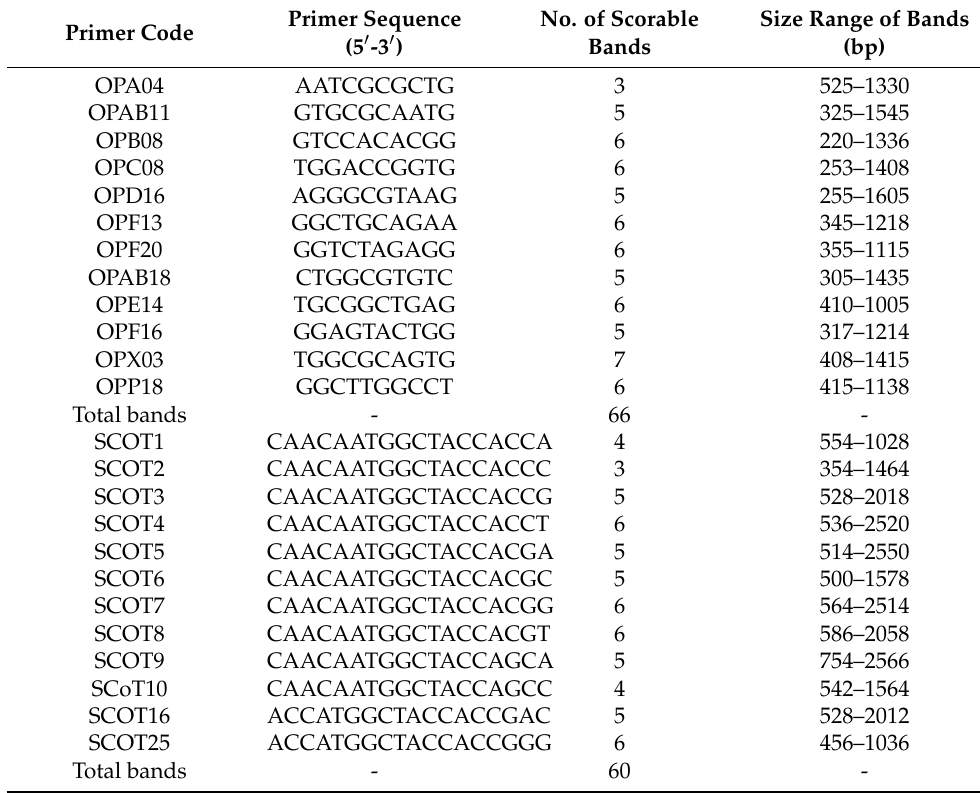
Figure 4. Analysis of the genetic fidelity of micropropagated H. Lupulus cv Cascade plants with their